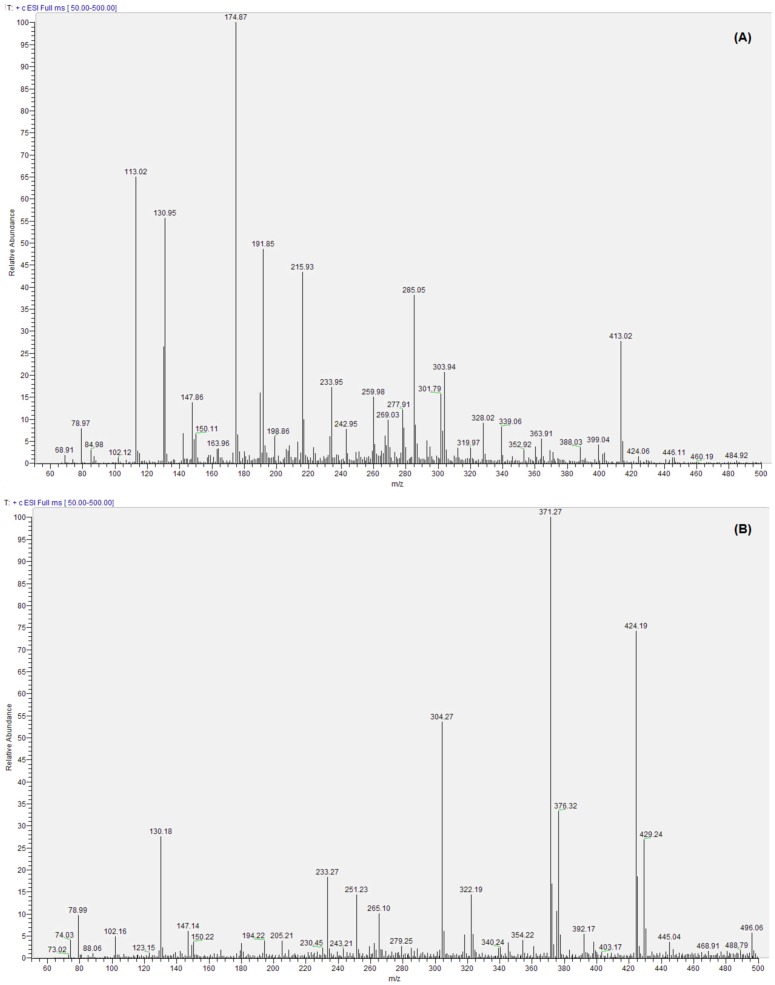
ESI+– MS spectrum of hamster serum.(A) control animals (B) animals treated with microencapsulated L. fermentum ATCC 11976. The decisive molecular ion [M+1]+ detected, only in the treatment group sera, was 371 in the MS spectrum, correlating to the addition of a glucuronic acid (m/z 176) to FA (m/z 194).